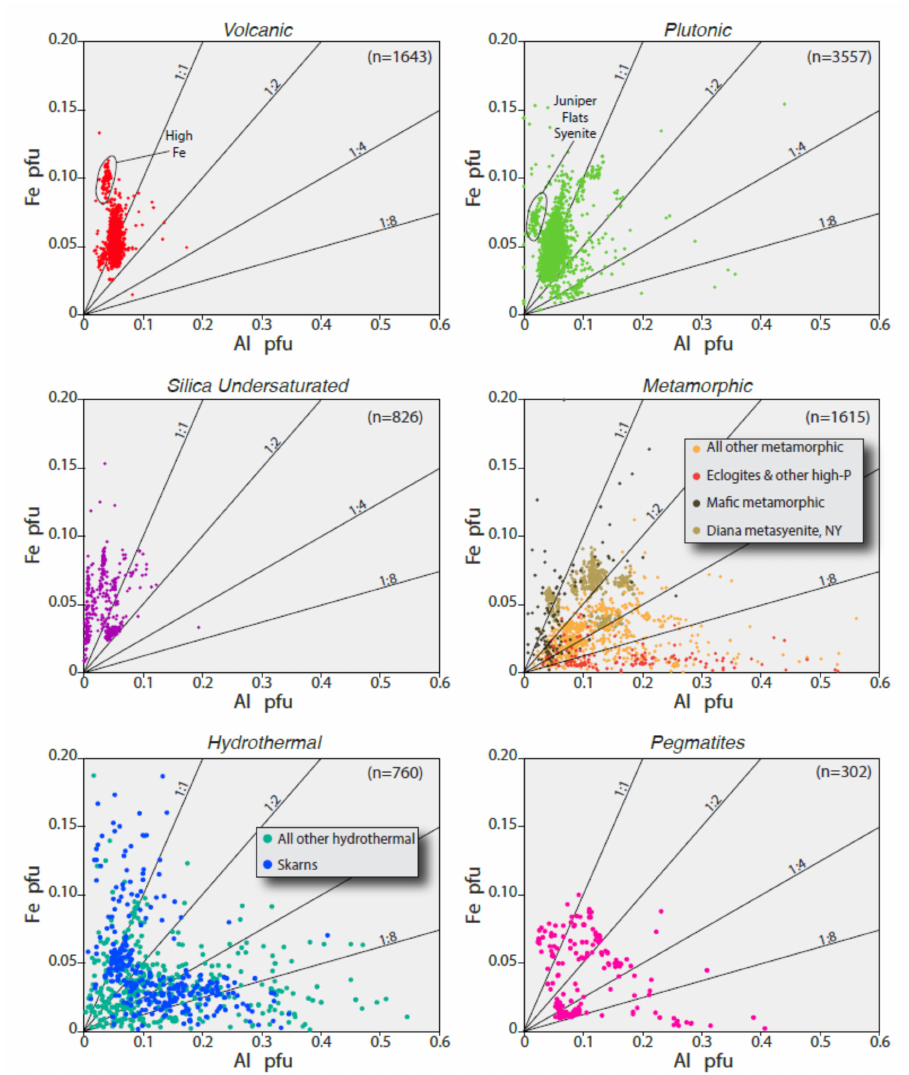
Figure 3. Fe versus Al in titanite from various environments. Lines of constant Fe/Al ratios from 2:1 to 1:8 are shown for reference. Hydrothermal includes titanite from skarns (dark blue) and metamorphic includes high-pressure eclogite and blue schist (orange), a large data set from the Diana metasyenite in New York [91], as well as titanite from mafic rocks such as metabasite and metabasalt